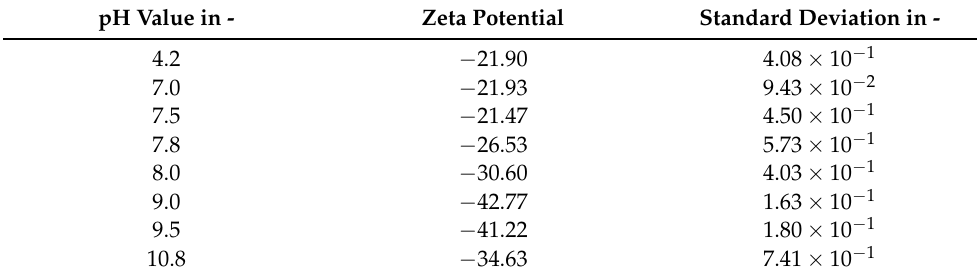
Table A5. Zeta potential values as a function of PVP content for a solution with 10 m% graphite